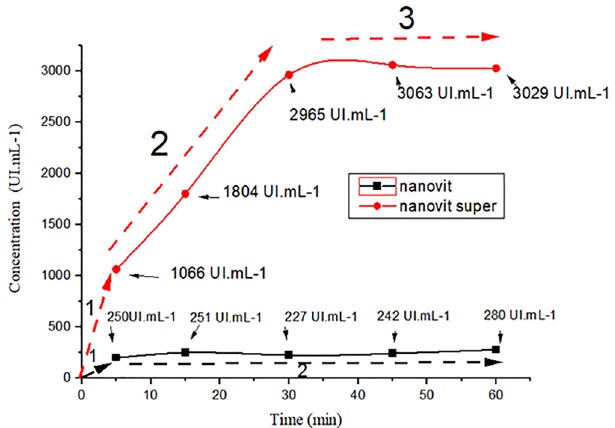
Figure 5. Release of vitamin D 3 from the nanovit and nanovit super membranes, as a function of time, obtained by absorbance measurements at 265